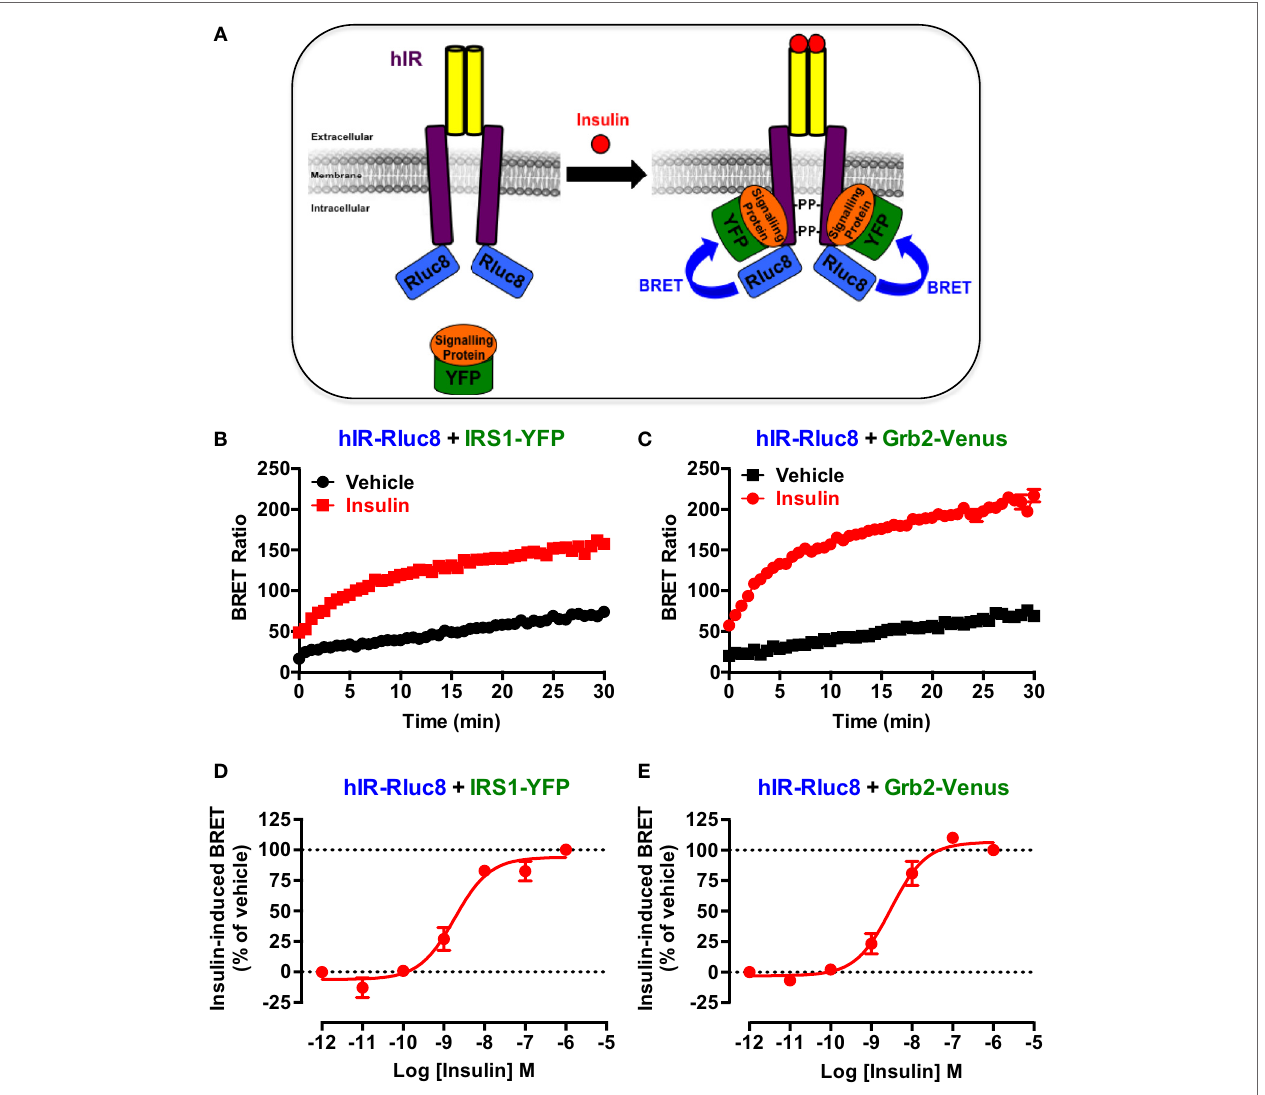
FigUre 1 | BreT assay to monitor hir activation. (a) Schematic representation of the BRET-based assay to monitor insulin-induced hIR activation through the detection of the physical proximity between hIR–Rluc8 and its YFP-tagged signaling proteins. For this, HEK293 cells transiently co-expressing hIR–Rluc8 with either IRS1–YFP (B,D) or Grb2–Venus (c,e) were stimulated (red circle) or not (black square) with 100 nM (B,c) or increasing doses (D,e) of insulin and BRET measurements were performed in real-time and live cells as described in Section “Materials and Methods.” Data are mean ± SEM of three to six independent experiments performed in